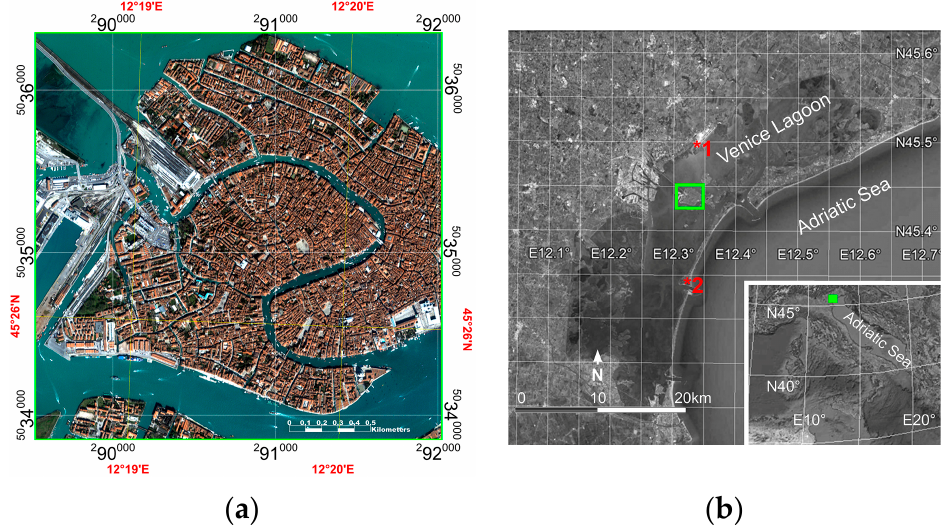
Figure 1. Study area: ( a ) IKONOS-2 image of study area; ( b ) study area location (green square) and locations of two intercalibration sites [57]: the runways of Marco Polo International Airport labeled with the number 1 and the Malamocco Golf Club labeled with the number 2.